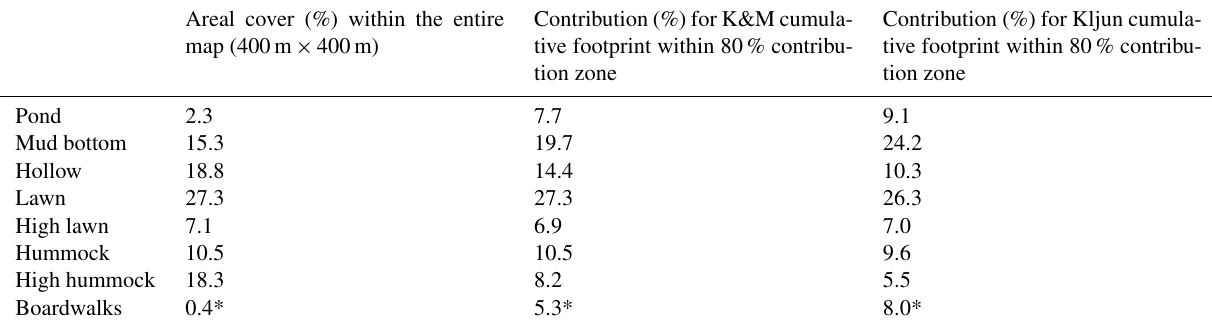
High hummock Boardwalks 0.4*